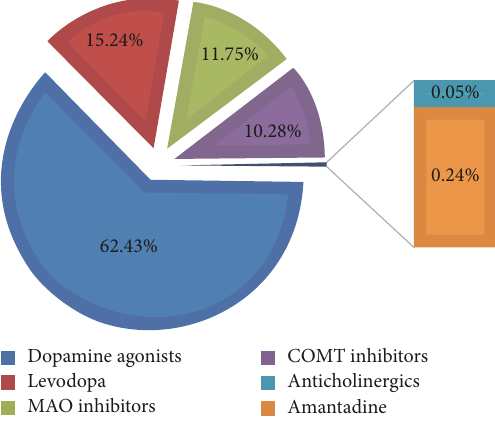
Figure 1: Direct costs of antiparkinsonian